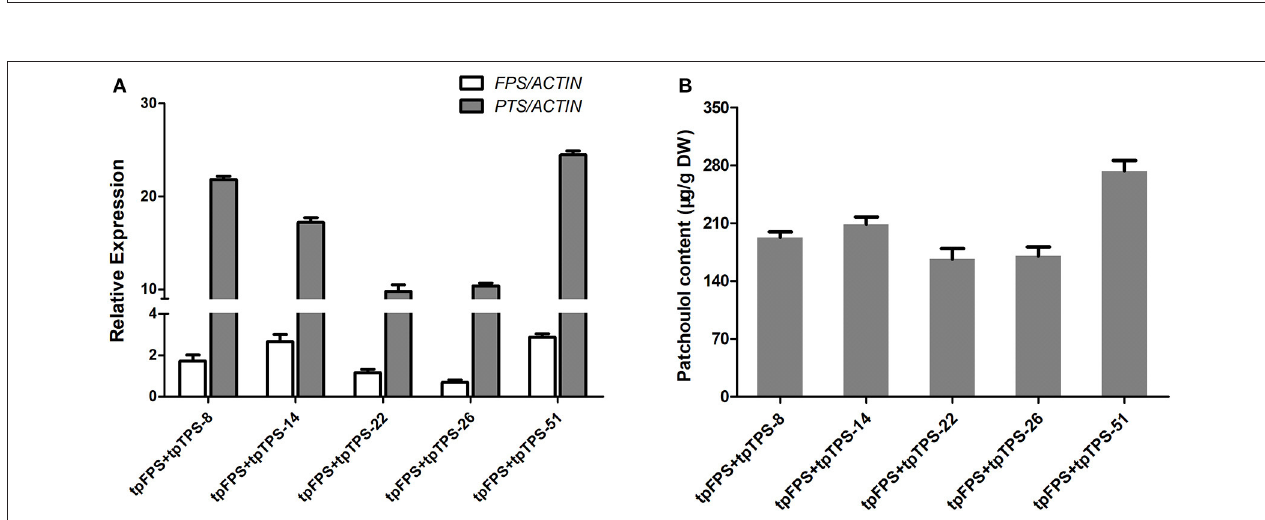
FIGURE 4 | The subcellular localization of heterologous proteins. (A) Subcellular localization of FPS-GFP and PTS-GFP in tobacco leaf epidermal cells. (B) Subcellular localization of tpFPS-GFP and tpPTS-GFP in tobacco leaf epidermal cells. GFP: green fluorescent protein, Bars = 20 µ m.